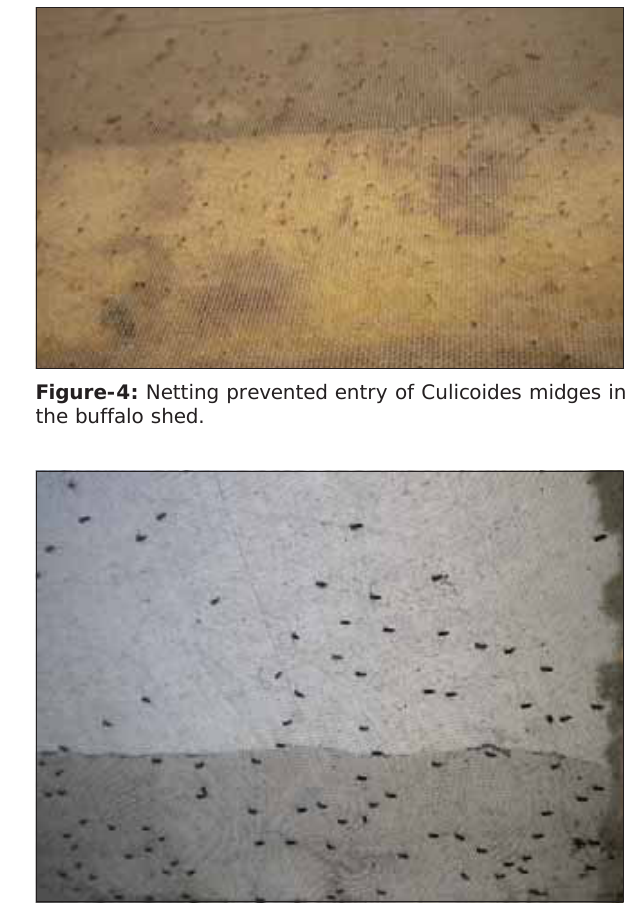
Figure-5: Netting prevented entry of mosquitoes in the buffalo shed.